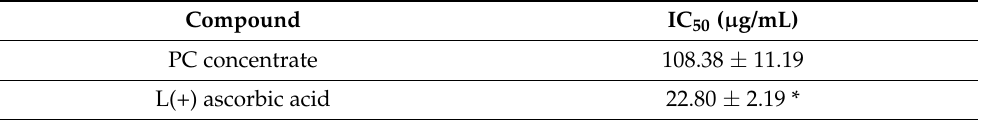
Table 4. Antioxidant activity parameters (IC 50 ) for PC concentrate into liposomes membrane. The oxidation was induced by AAPH.